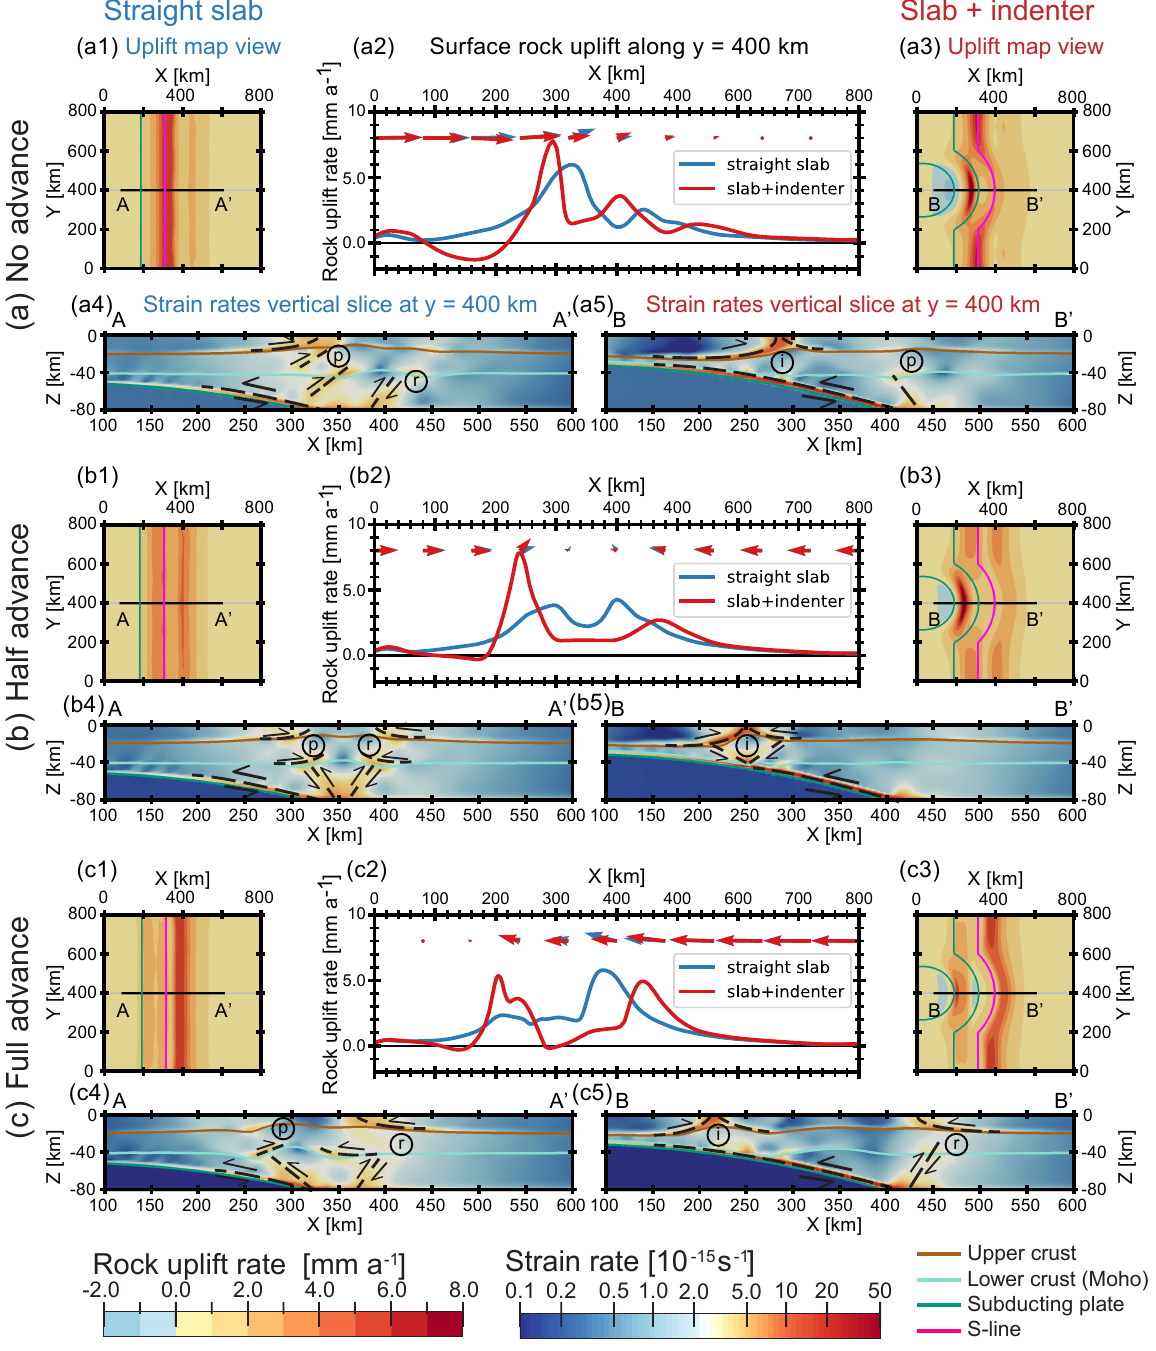
Figure 4. Effect of indenter geometry on rock uplift and strain rates for models 1–6 (Table 1). For each of the three upper-plate motion scenarios a – c , panels (1) and (3) show the plan view distribution of rock uplift rates (vertical component of velocity) for the straight-slab and indenter geometry, respectively. Magenta lines mark the position of the S line, and dark green lines are indenter contours at 40 and 60km depth. (2) Rock uplift rates at the surface along dip at y = 400km (gray line in 1 and 3 ). Arrows indicate orientation of total velocity. (4) and (5) show strain rates for vertical slice along dip at y = 400km (black line in 1 and 3 ). Brown, light green, and dark green indicate the material boundaries between upper plate, lower plate, and lithospheric mantle, respectively. Pro- and retro-shear zone are labeled (p) and (r), respectively; indenter detachment is labeled (i). In all scenarios, the indenter gives rise to an ellipsoidal region of increased uplift above its apex, caused by the indenter detachment that accommodates shortening in the indenter’s